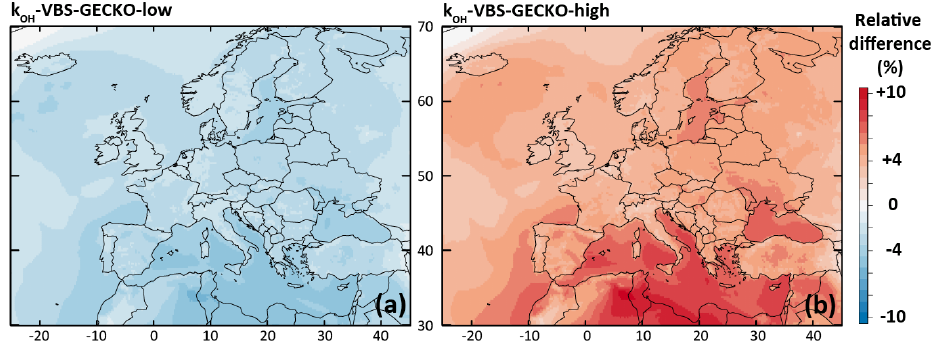
Figure 6. Relative differences on the simulated mean OA concentrations between (a) the k OH -VBS-GECKO-low and the ref-VBS-GECKO model configurations and (b) the k OH -VBS-GECKO-high and the ref-VBS-GECKO model configurations for the 2-month